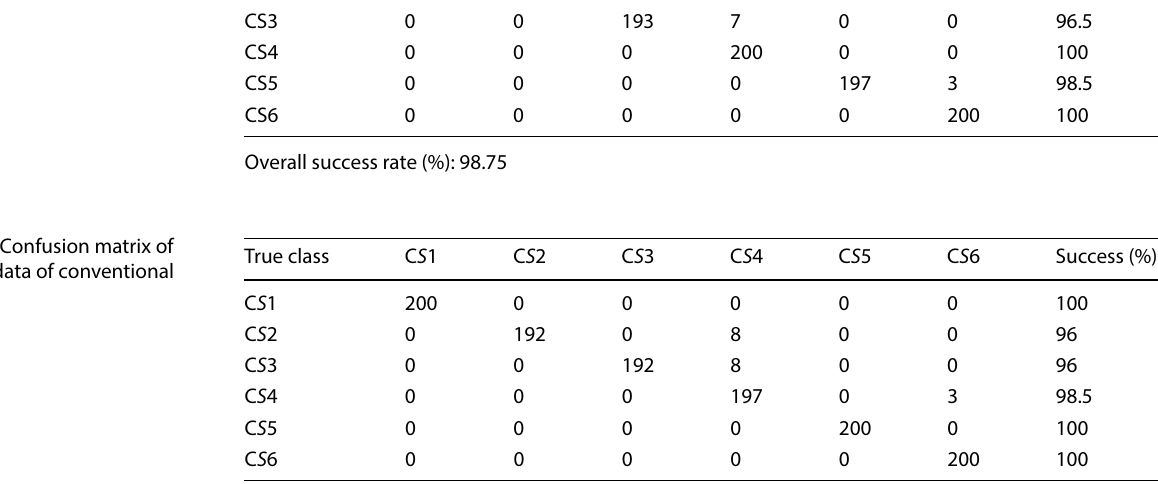
Table 8 Confusion matrix of training data of conventional ELM